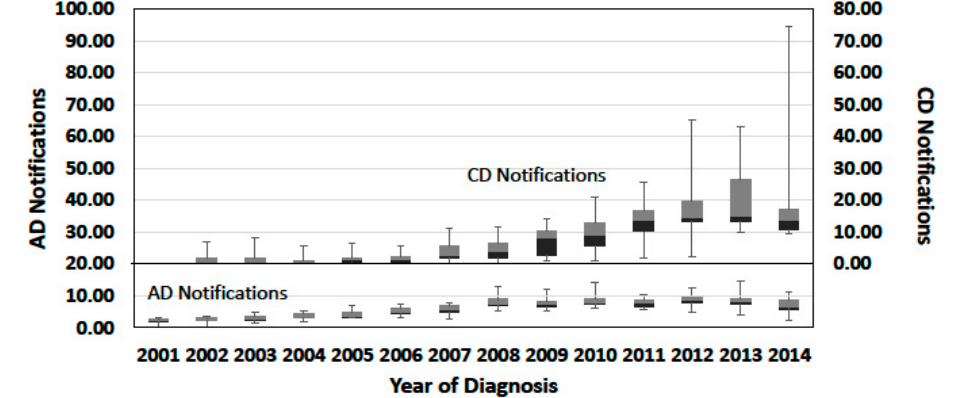
Figure 1. Time course of notifications, by year of diagnosis ascertainment or certification. Dataset: Subset 1; Origin of notifications: Regions using the record structure with the Date of diagnosis Ascertainment (AD) and regions using the record structure with the Date of diagnosis Certification (CD); Selection of records: Records with valid diagnosis ascertainment or certification date; Total